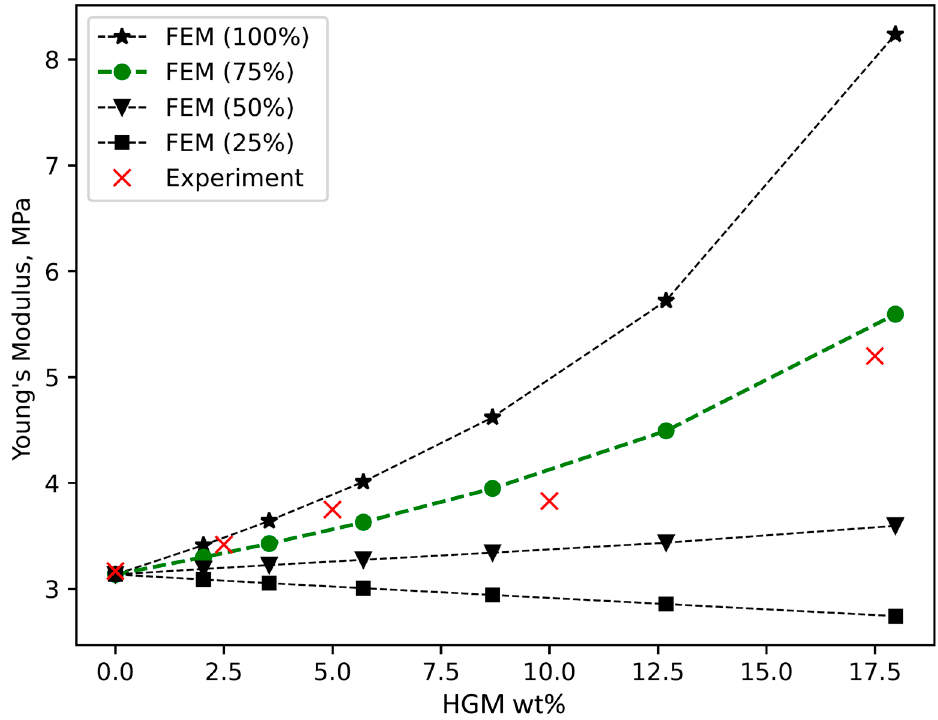
Figure 5. The dependence of the Young’s modulus of PDMS-HGMs composite on HGMs content. Experimental results (red crosses) are given alongside with FEM calculations.